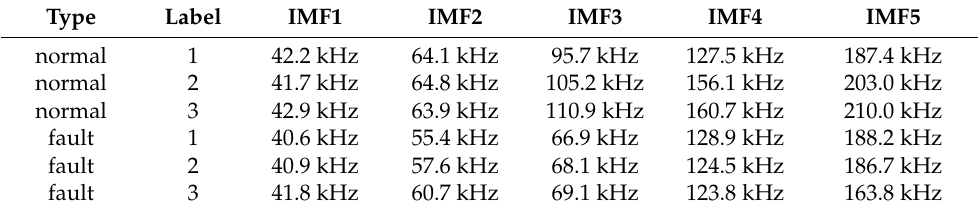
Table 3. K = 5, the center frequency of IMFs after VMD of multiple sets of data.